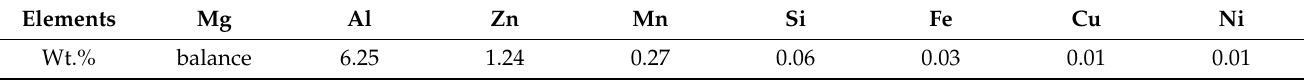
Table 1. The chemical composition of